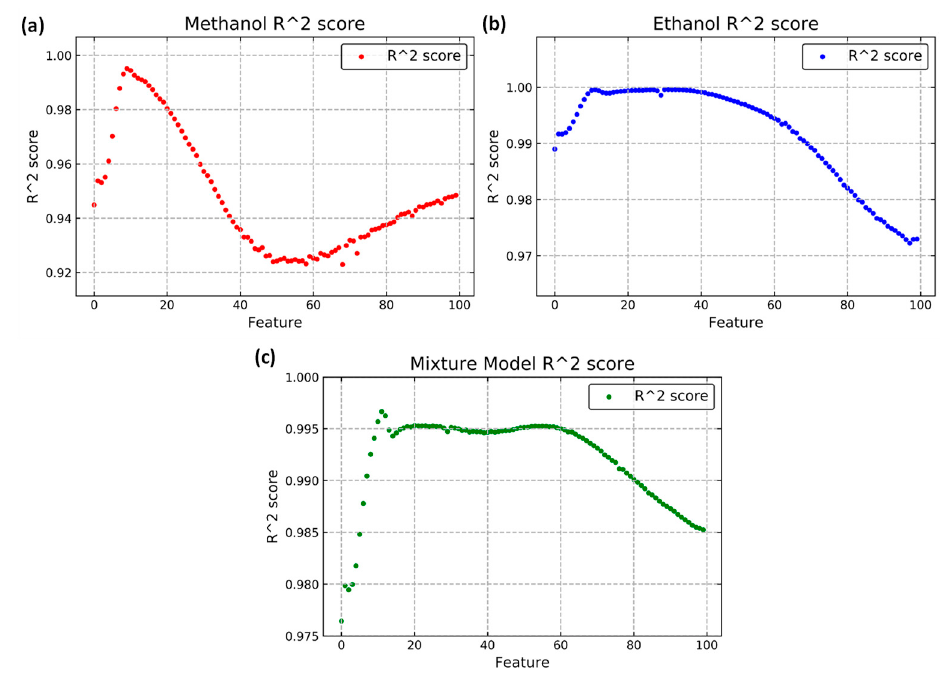
Figure 8. R 2 score obtained with the power law for each gas: ( a ) Methanol and ( b ) ethanol; ( c ) R 2 score obtained with the mixture model for all data.